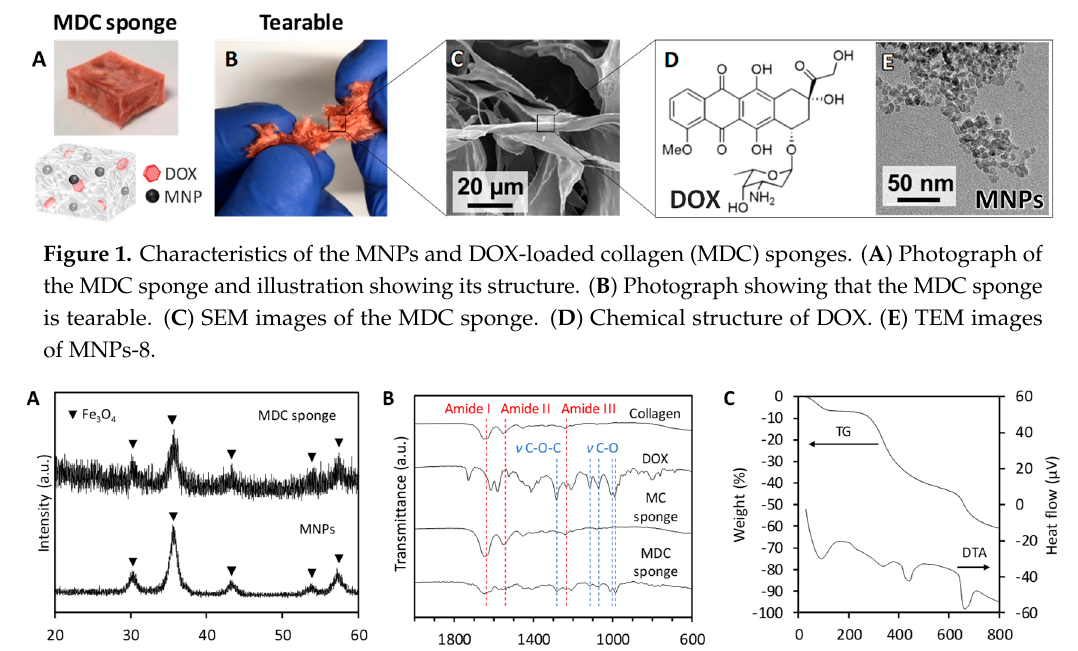
Figure 2 . The diffraction peaks of magnetite were detected in the X-ray diffraction (XRD) patterns ( A ) XRD patterns of the magnetite nanoparticles (MNPs) and DOX-loaded collagen (MDC) sponge and MNPs. ( B ) FTIR spectra of collagen, DOX, MC sponge, and MDC sponge. ( C ) Thermogravimetric and differential thermal analysis (TG-DTA) curves of MDC sponge.